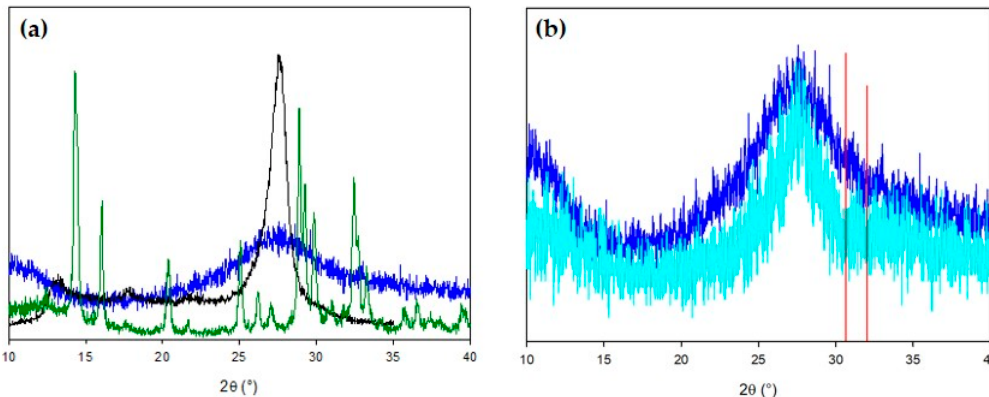
Figure 5. XRD patterns collected on ( a ) DMASnBr 3 (green), g-C 3 N 4 (black) and as-prepared DMASnBr 3 /g-C 3 N 4 (blue); ( b ) the composite after three irradiations (azure) compared to the as-prepared one (blue) and reference metallic tin (red).